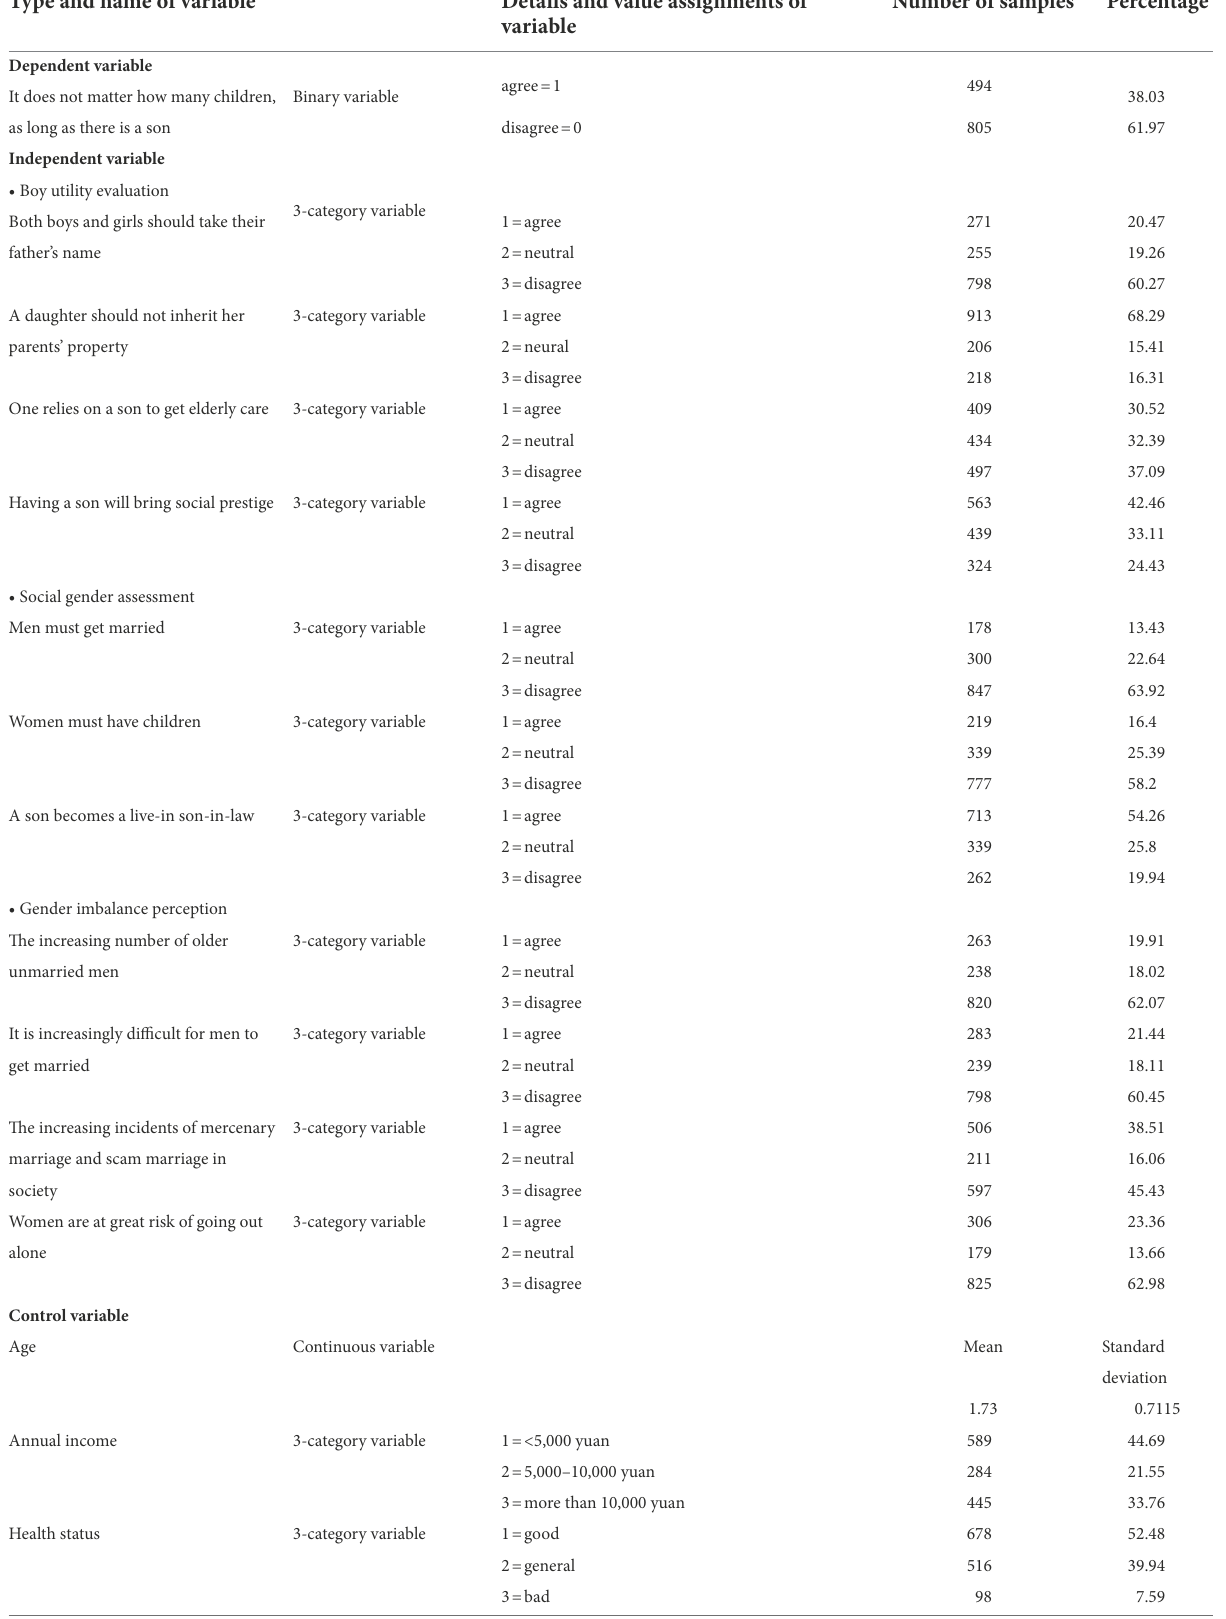
TABLE 1 Meanings of variables and characteristics of